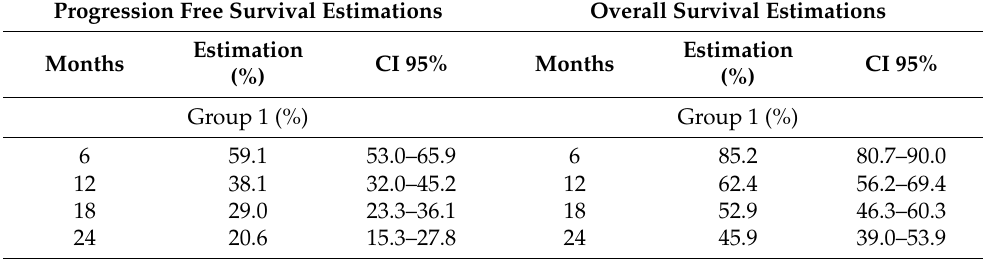
Six months, 12 months, 18 months, and 24 months estimated PFS and OS are detailed in Table 5. Table 5. Estimated PFS and OS. Progression Free Survival